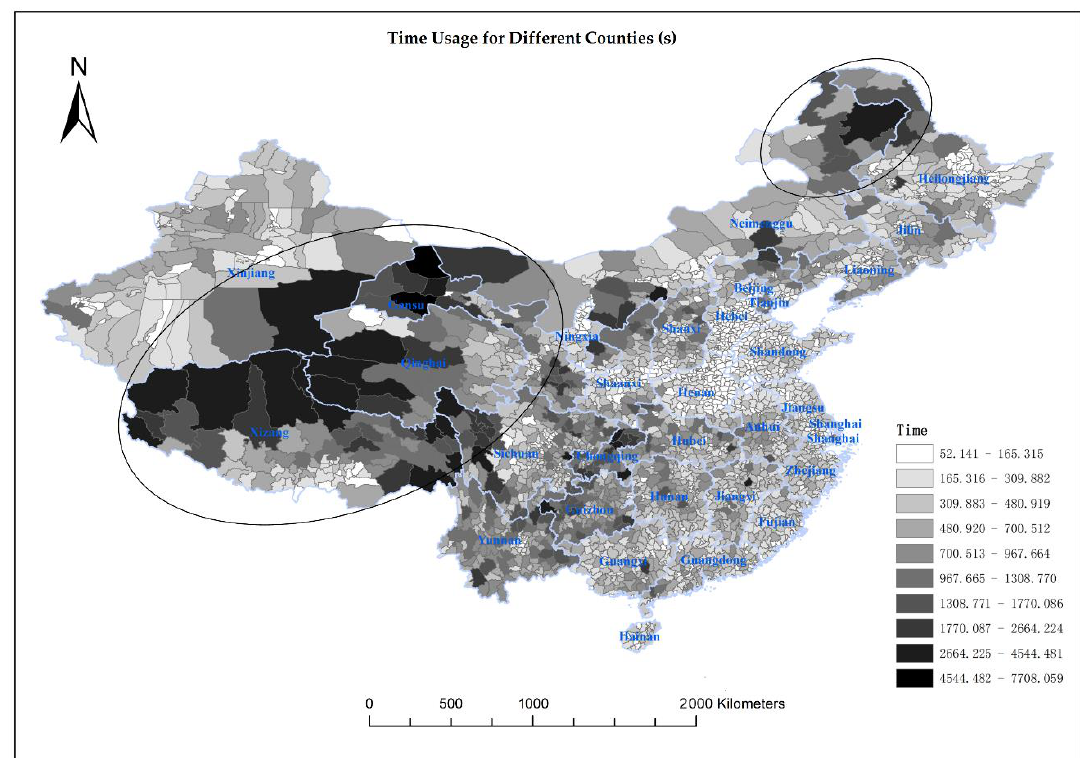
Figure 10. Estimated time usage in the 2858 counties in China.